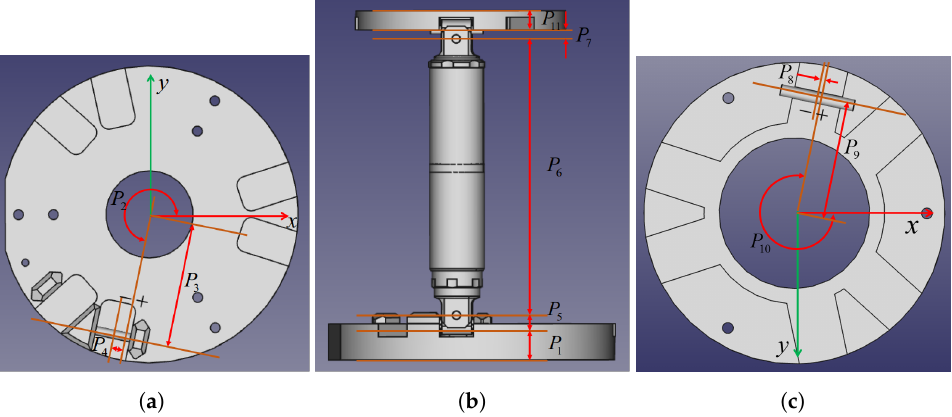
Figure 4. Geometric parameters for one chain: ( a ) top view of the mounting base; ( b ) side view of the linear actuator; ( c ) bottom view of the moving